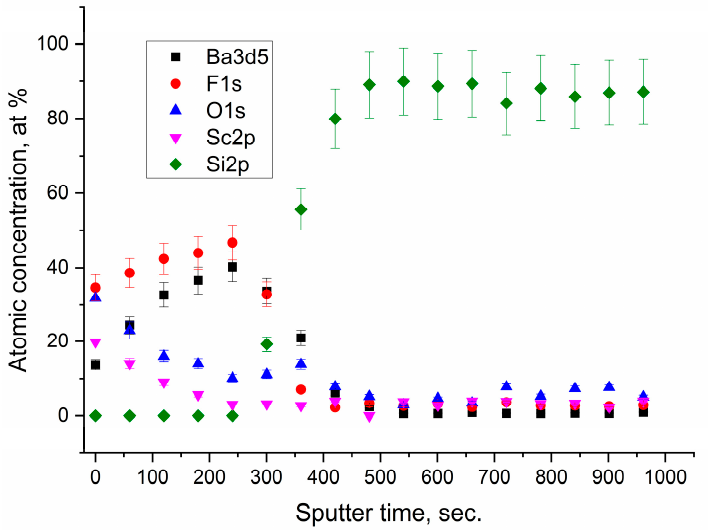
Figure 6. XPS depth profile of the sample with the BaF 2 thin film between the Sc 2 O 3 and the Si substrate.